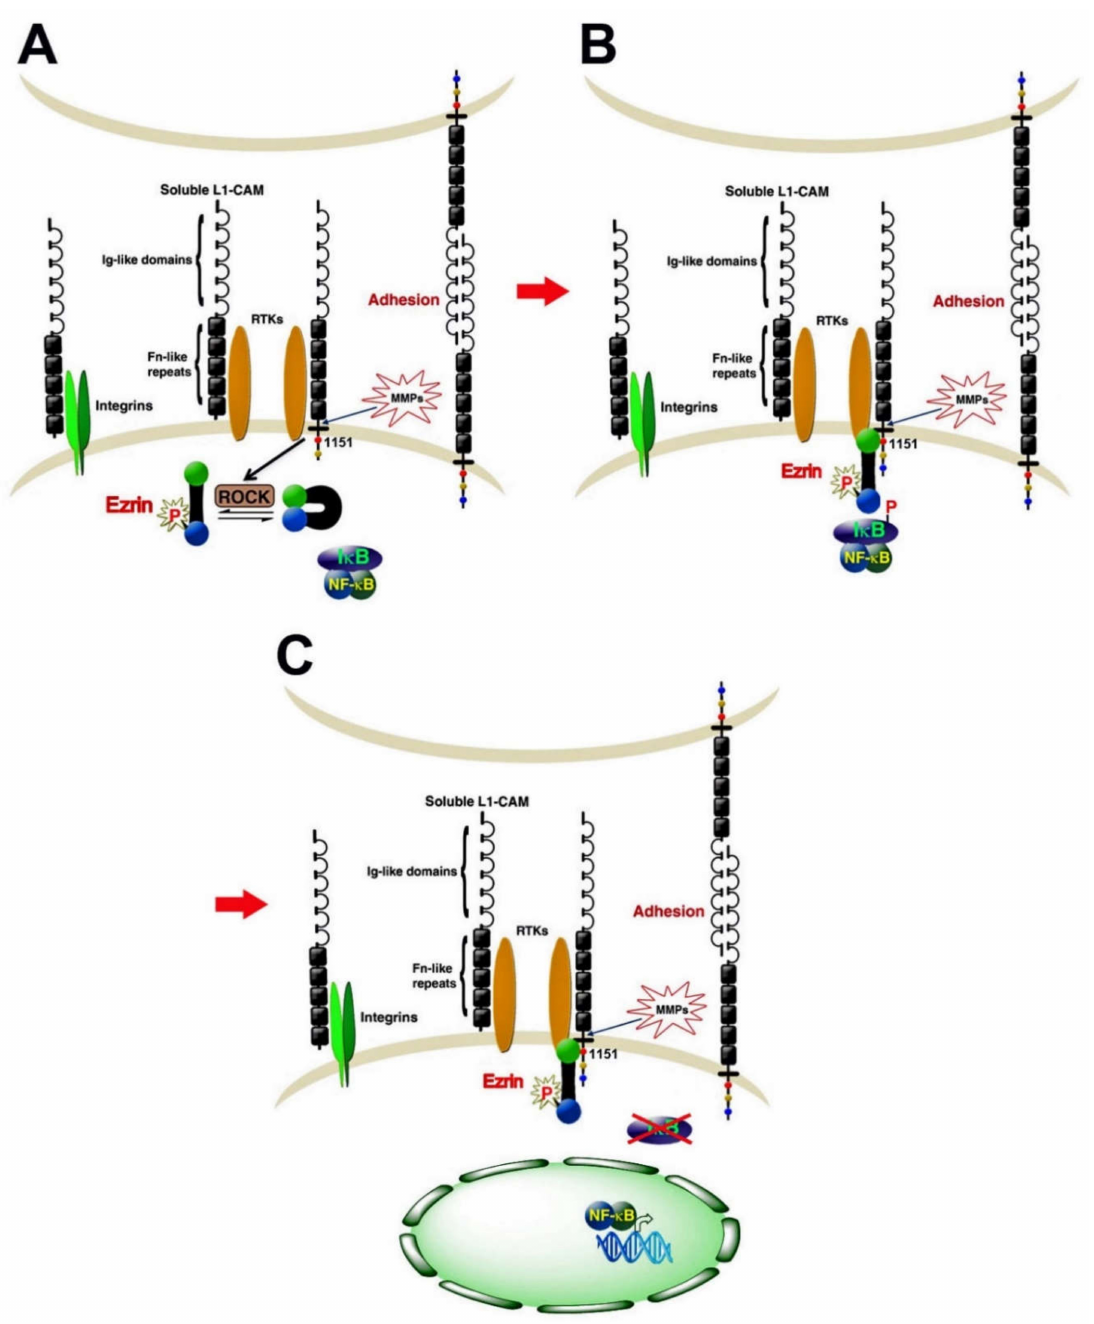
Figure 3. An NF- κ B-ezrin signaling pathway is involved in L1 signaling in CRC cells. ( A )